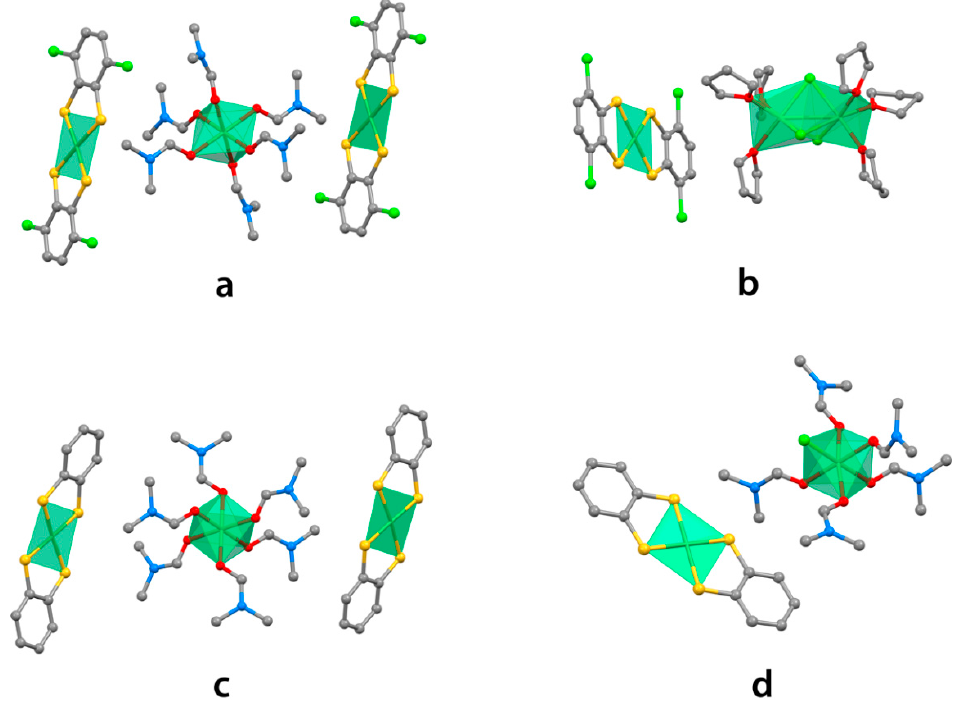
Figure 1. Ionic species per formula unit found in the dithiolene derivatives: a , [Ni(DMF) 6 ] [Ni(SC 6 H 2 Cl 2 S) 2 ] 2 1 ; b , [Ni 2 ( µ -Cl 3 )(THF) 6 ][Ni(SC 6 H 2 Cl 2 S) 2 ] 4 ; c , [Ni(DMF) 6 ][Ni(SC 6 H 4 S) 2 ] 2 5 ; and d , [Ni(DMF) 5 Cl][Ni(SC 6 H 4 S) 2 ] 6 . Green octahedra and square planar geometries represent Ni coordination environments. Oxygen atoms are depicted in red, sulfur ones in yellow, nitrogen in blue, chlorine in light green, and carbon in grey. Solvent molecules and hydrogen atoms have been omitted for clarity.